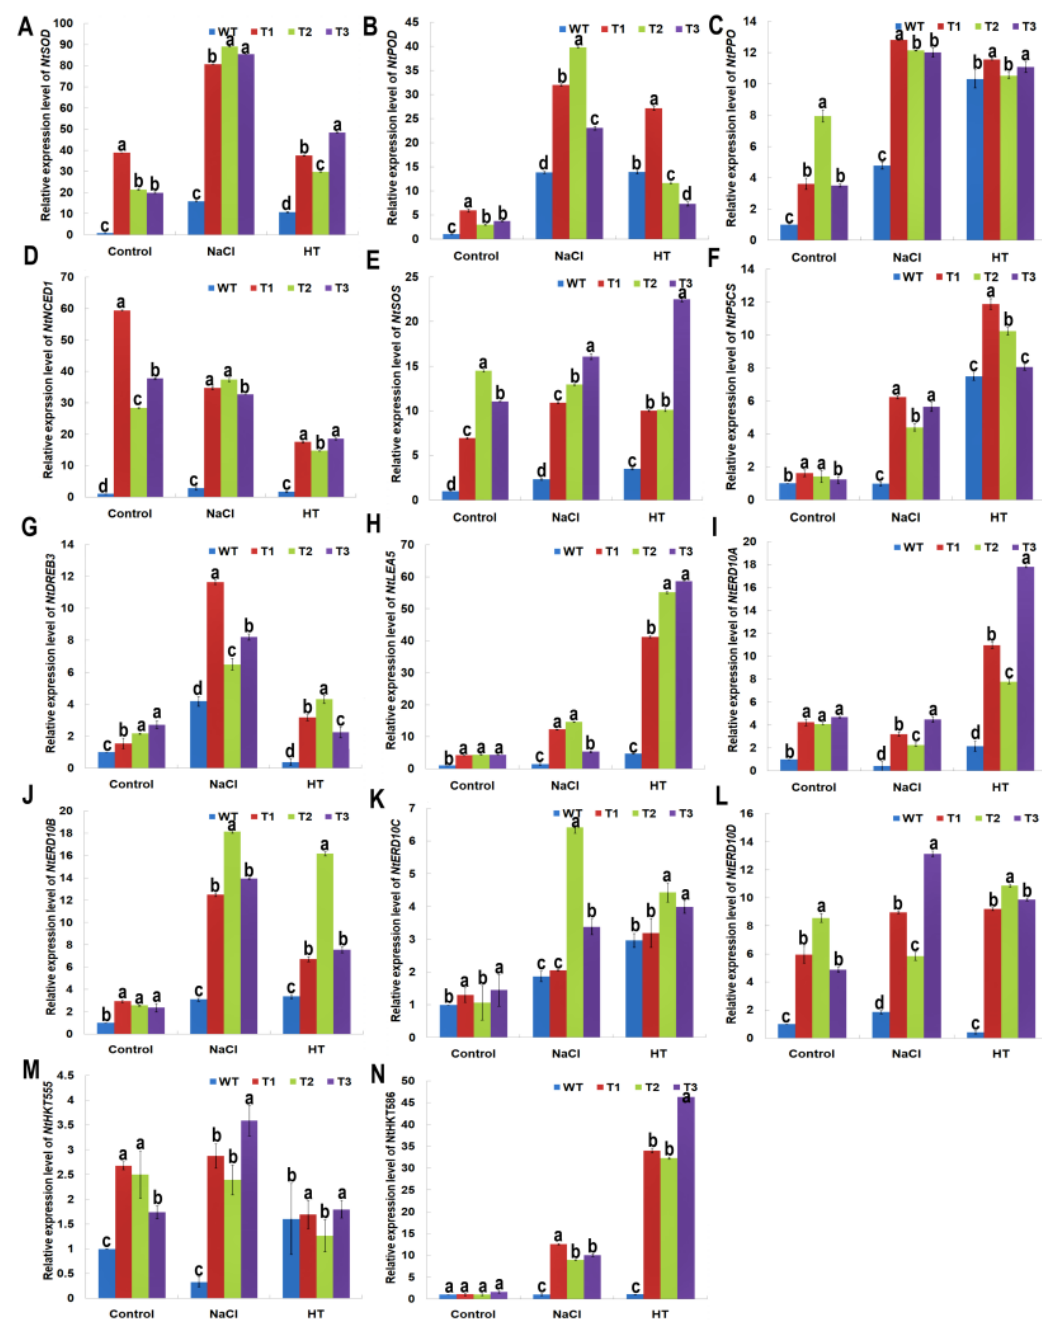
Figure 7. Genes expression profiling of stress-responsive genes in the PsnNAC036 transgenic plants under NaCl and HT treatments. The relative fold change in expression of ( A ) NtSOD ; ( B ) NtPOD ; ( C ) NtPPO ; ( D ) NtNCED1 ; ( E ) NtSOS ; ( F ) NtP5CS ; ( G ) NtDREB3 ; ( H ) NtLEA5 ; ( I ) NtERD10A ; ( J ) NtERD10B ; ( K ) NtERD10C ; ( L ) NtERD10D ; ( M ) NtHKT555 ; ( N ) NtHKT586 genes in the PsnNAC036 transgenic lines under control, high salt and heat conditions. The statistical analysis was done using a one-way ANOVA with a post-hoc with Tukey lines with an alpha value of 0.05. Different letters indicate significant difference between sites.